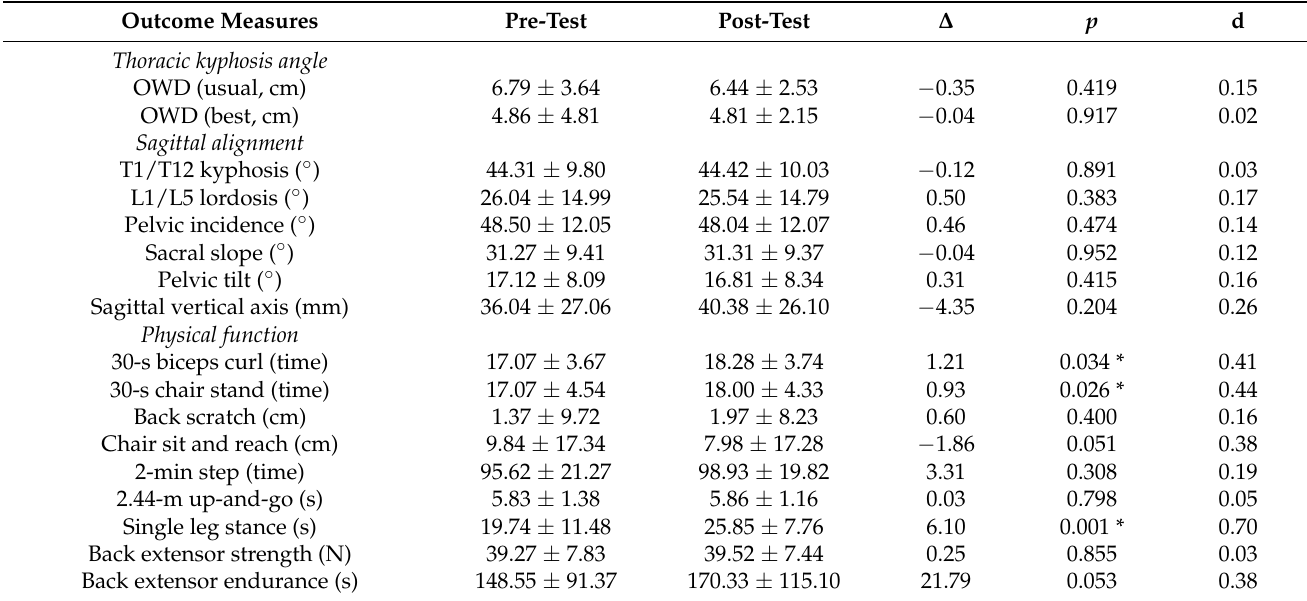
Table 2. Changes in outcome measures before and after the pole walking exercise program.